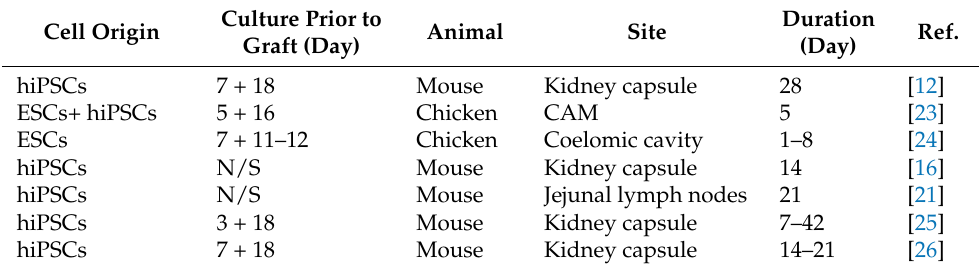
Table 1. Comparison of transplantation